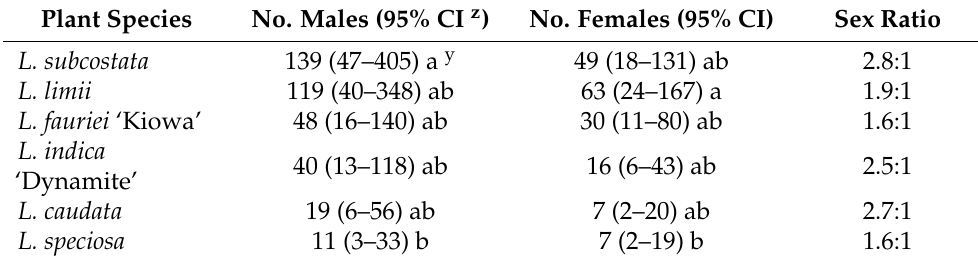
Table 2. The least squares means of the male and female Acanthococcus lagerstroemiae and sex ratio (male–female) on different Lagerstroemia species within 25 weeks after inoculation. Plant Species No. Males (95% CI z ) No. Females (95%